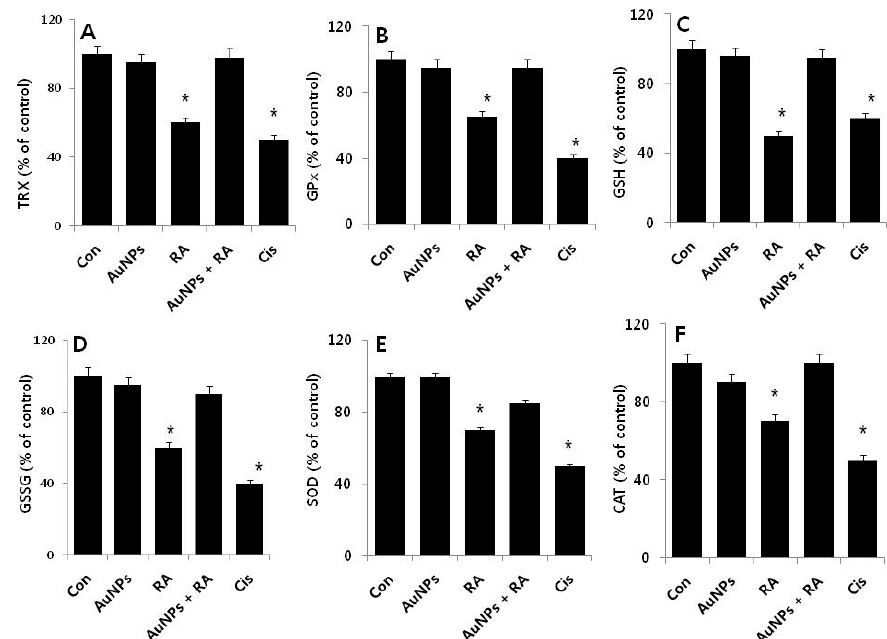
Figure 7. Effect of AuNPs and RA on the expression of anti-oxidative stress markers in F9 cells. F9 cells were treated with AuNPs (10 µ M), RA (10 µ M), and RA in the presence of AuNPs (both 10 µ M) for 24 h. After incubation, the cells were harvested and washed twice with ice-cold PBS solution. The cells were collected and disrupted by ultrasonication for 5 min on ice. ( A ) The concentration of TRX was measured as nanomole/mg protein; ( B ) The specific activity of GPx measured as unit per mg protein; ( C ) GSH was measured as mg/g protein; ( D ) The ratio GSSG was measured as mg/g protein; ( E ) The specific activity of SOD was measured as unit/mg protein; ( F ) The specific activity of CAT was expressed as unit/mg protein. The results are expressed as mean ± standard deviation of three independent experiments. There was a significant difference in the treated cells compared to that of the untreated cells by the Student’s t -test (* p , 0.05).